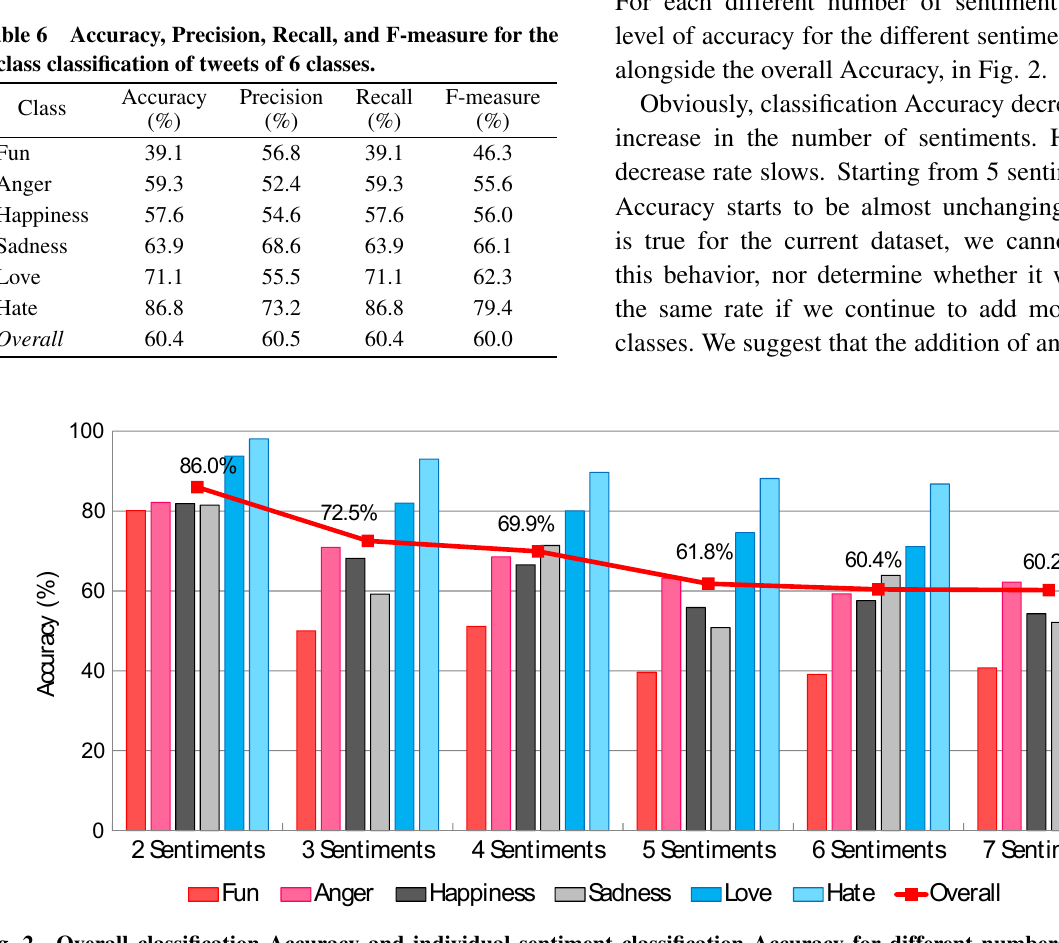
Fig. 2 Overall classification Accuracy and individual sentiment classification Accuracy for different numbers of sentiment